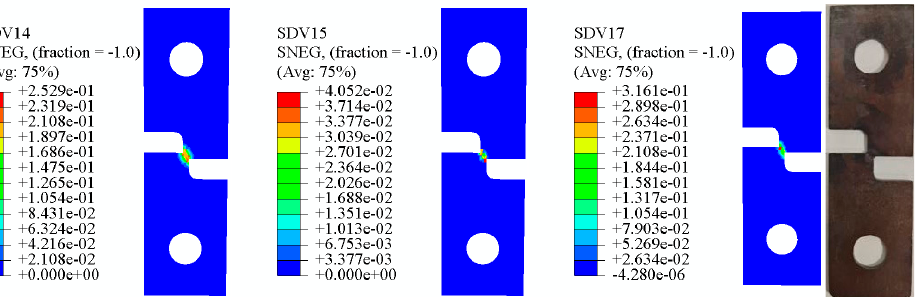
Figure 14. Equivalent plastic strain, VVF, shear damage at the beginning of microcrack in 30 ◦ specimen, and the result diagram of specimen.